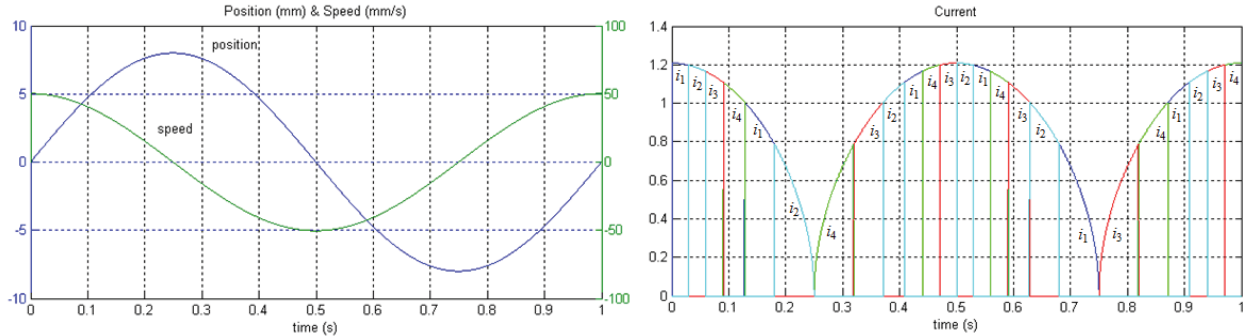
Figure 6. Generation of the phase currents according to the reference